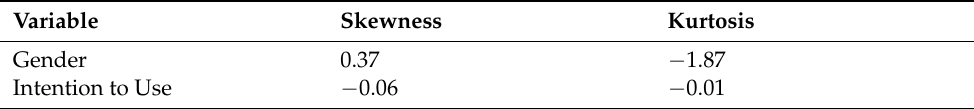
Table 1. Normality test based on skewness and kurtosis values. Variable Skewness Kurtosis Gender 0.37 − 1.87 Intention to